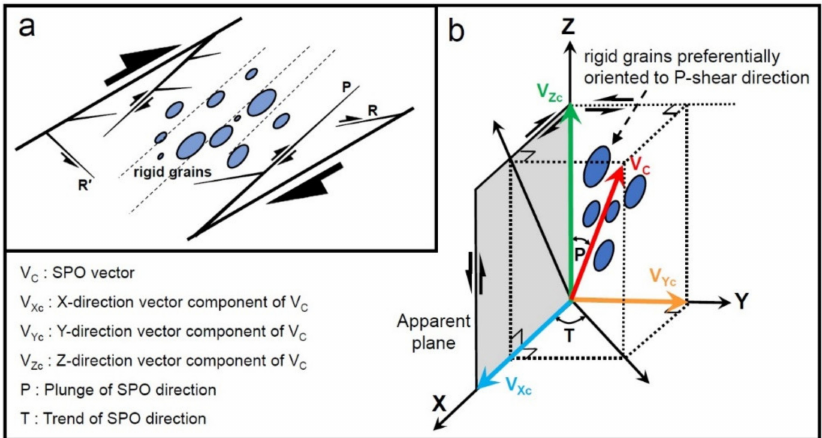
Figure 1. ( a ) Arrangement of grain preferred orientation and direction of shear according to the Riedel shear model in outcrop (2-D plane). ( b ) Schematic diagram showing the arrangement of grains viewed in 3D with apparent planes observed in the outcrop. SPO can be expressed as the sum of each direction vector on the